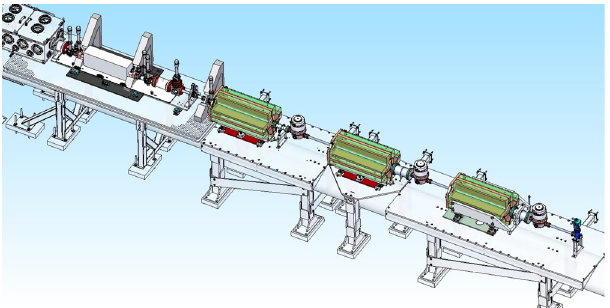
FIG. 12. Downstream differential pumping and imaging spec- trometer quadrupole